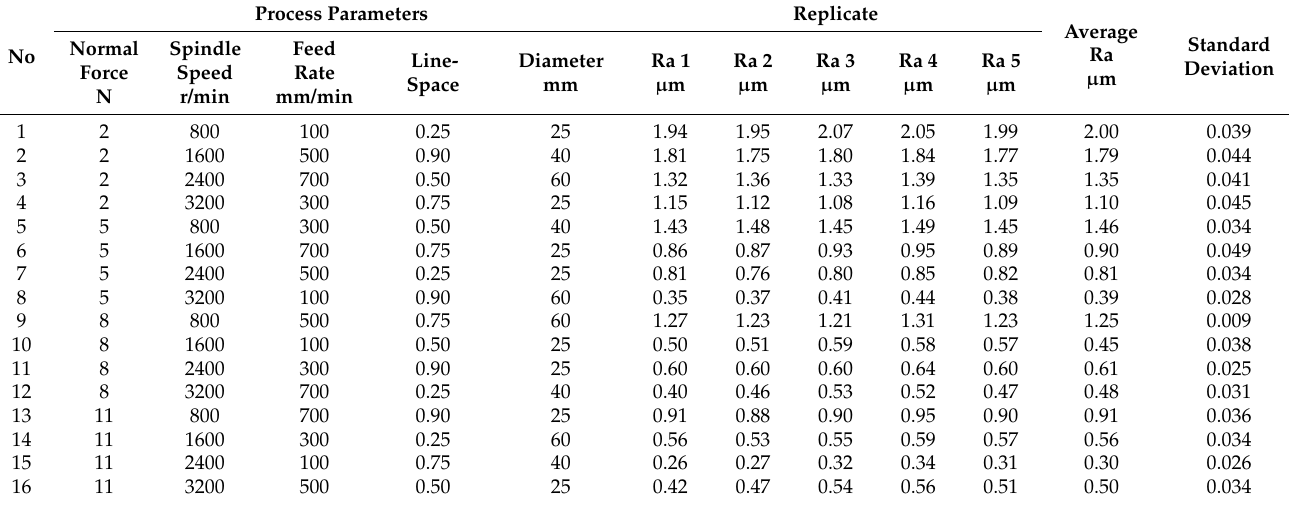
Figure 5. Variations of surface topography under different process parameters. Table 2. L 16 Orthogonal